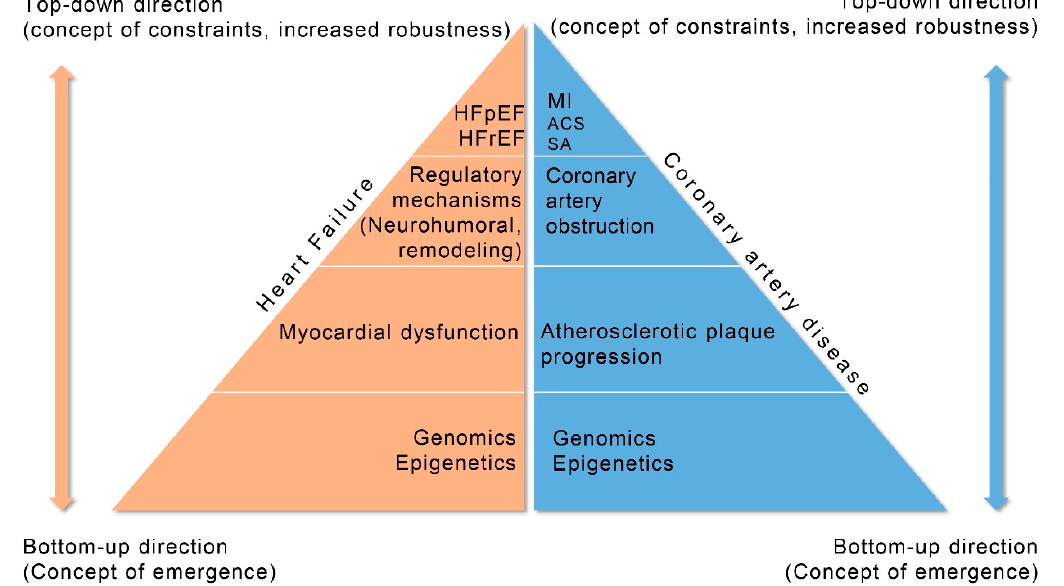
Figure 4. Progression of coronary artery disease (CAD) and heart failure (HF) explained by systems biology approach. HFpEF (Heart Failure with Preserved Ejection Fraction), HFrEF (Heart Failure with Reduced Ejection Fraction), MI (Myocardial Infarction), ACS (Acute Coronary Syndromes), SA (Stable Angina).